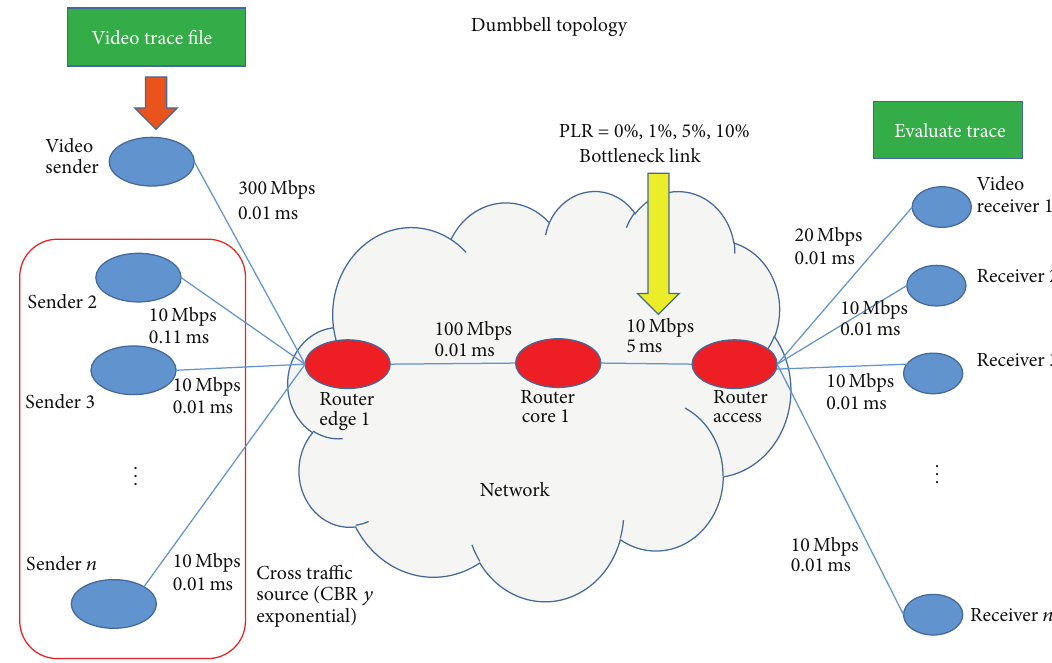
Figure 3: Simulation scenery with NS-2 and Evalvid.